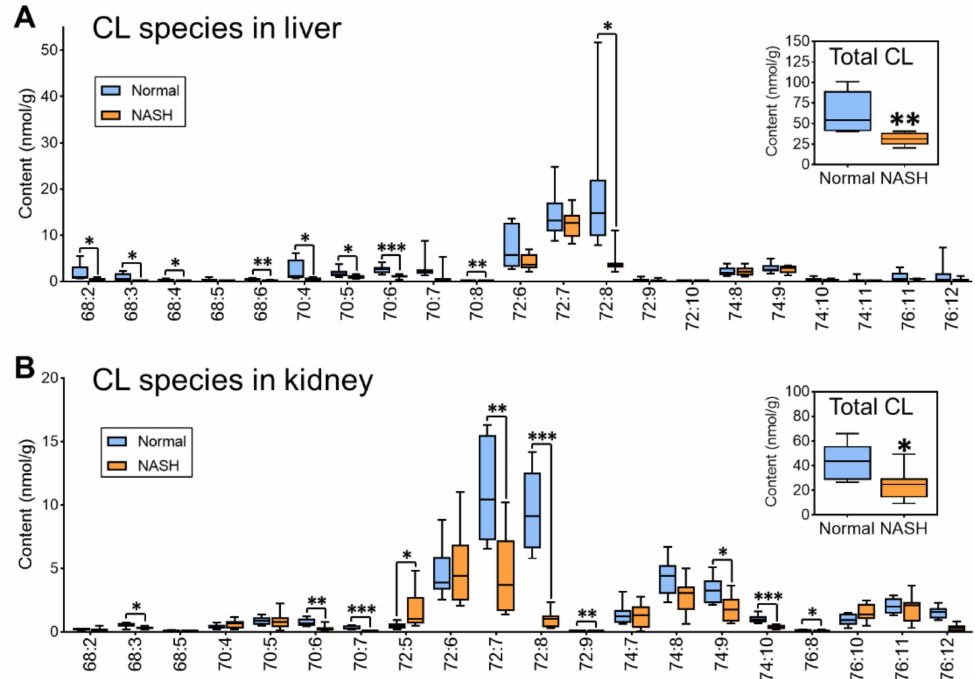
Figure 4. Comparison of the CL species and the total CL between normal and NASH groups in the liver ( A ) and the kidney ( B ). * p < 0.05, ** p < 0.01, *** p < 0.001, calculated by two-tailed t